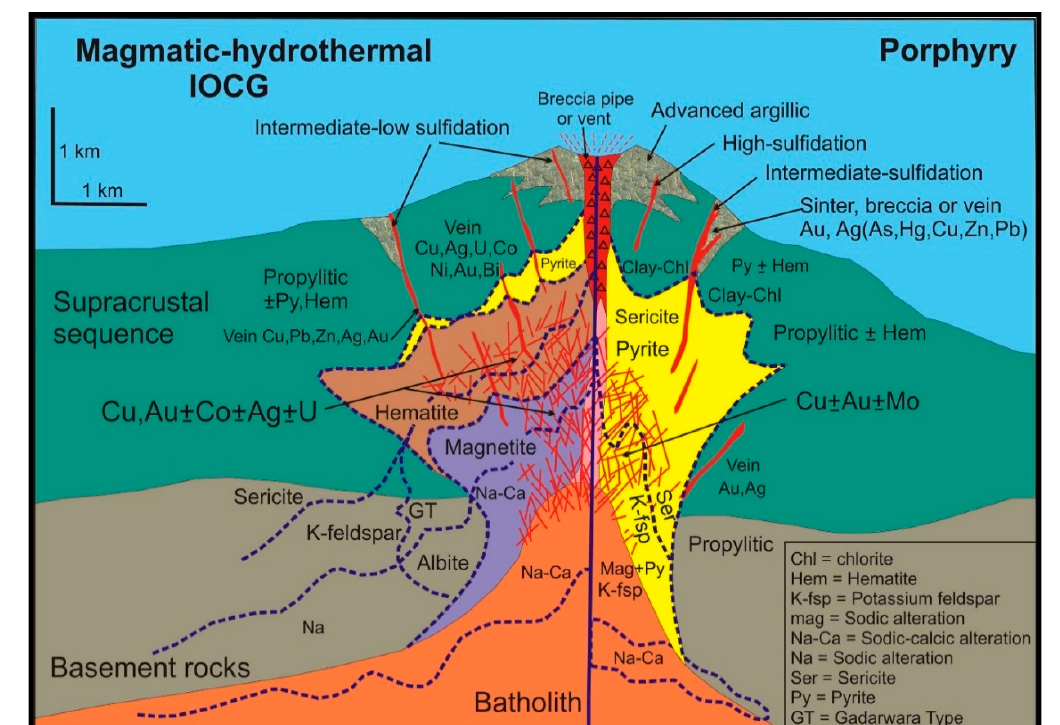
Figure 12. Modified Schematic model for Magmatic-hydrothermal systems illustrating relationship between S-rich porphyry Cu ± Mo ± Au deposits (right side) and S-poor Magmatic-hydrothermal iron oxide-copper-gold (MH-IOCG) deposits (left side). Approximate hydrothermal mineral transitions and relative spatial footprint are shown for albite–K-feldspar, K-feldspar–sericite, and magnetite-hematite transitions. Prograde and retrograde overprinting of alteration assemblages and mineralization is common. Spatial relationships for porphyry deposits after Seedorff et al. (2005) [50], Sillitoe (2010) [51], and Richards (2011) [52]; for MH-IOCG, after Hitzman et al. (1992) [48], Williams et al. (2005) [49], and Mumin et al. (2010) [53]. (Figure modified under “Fair- Use” permission from